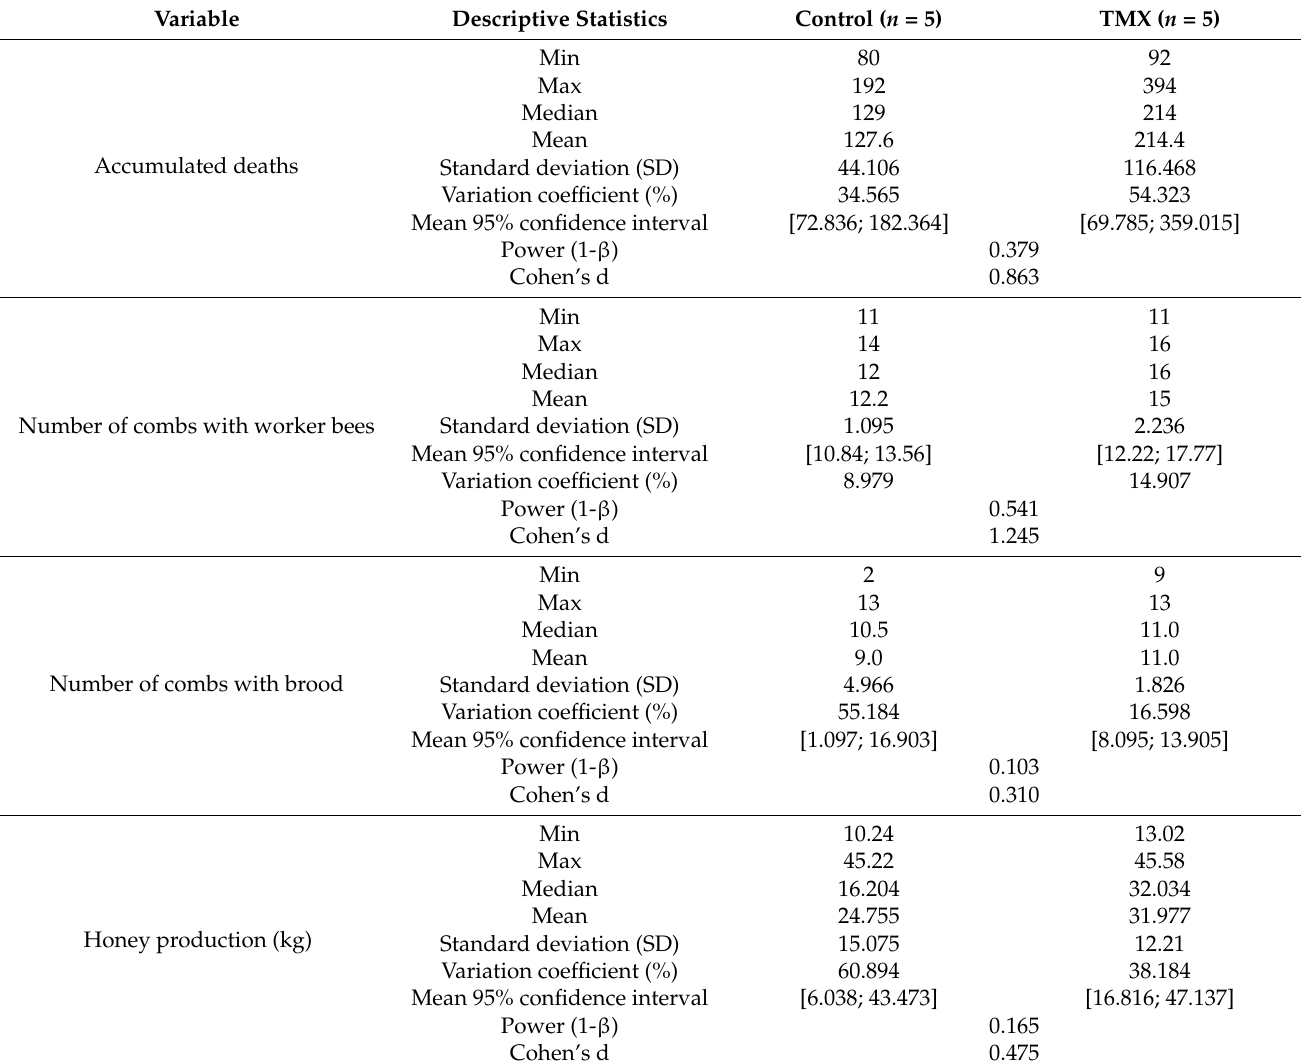
Table 2. Descriptive statistics of the variables of strength in control and treatment (TMX) apiaries at the end of the exposure